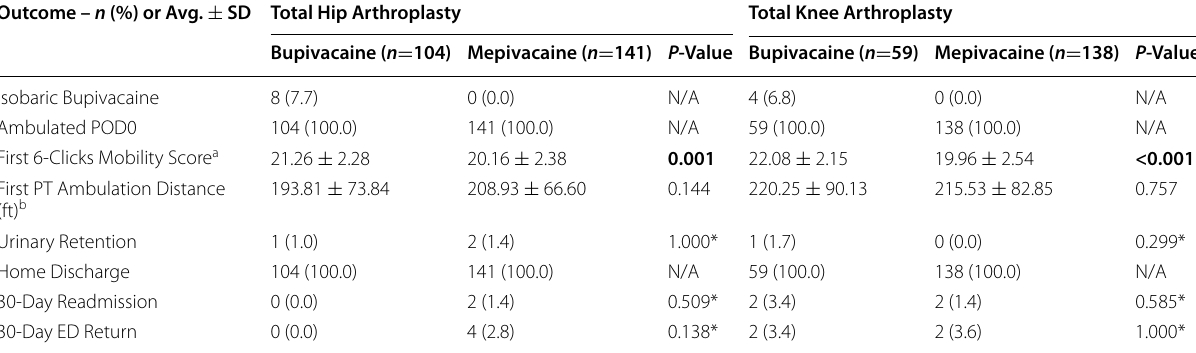
P -Values <0.05 in